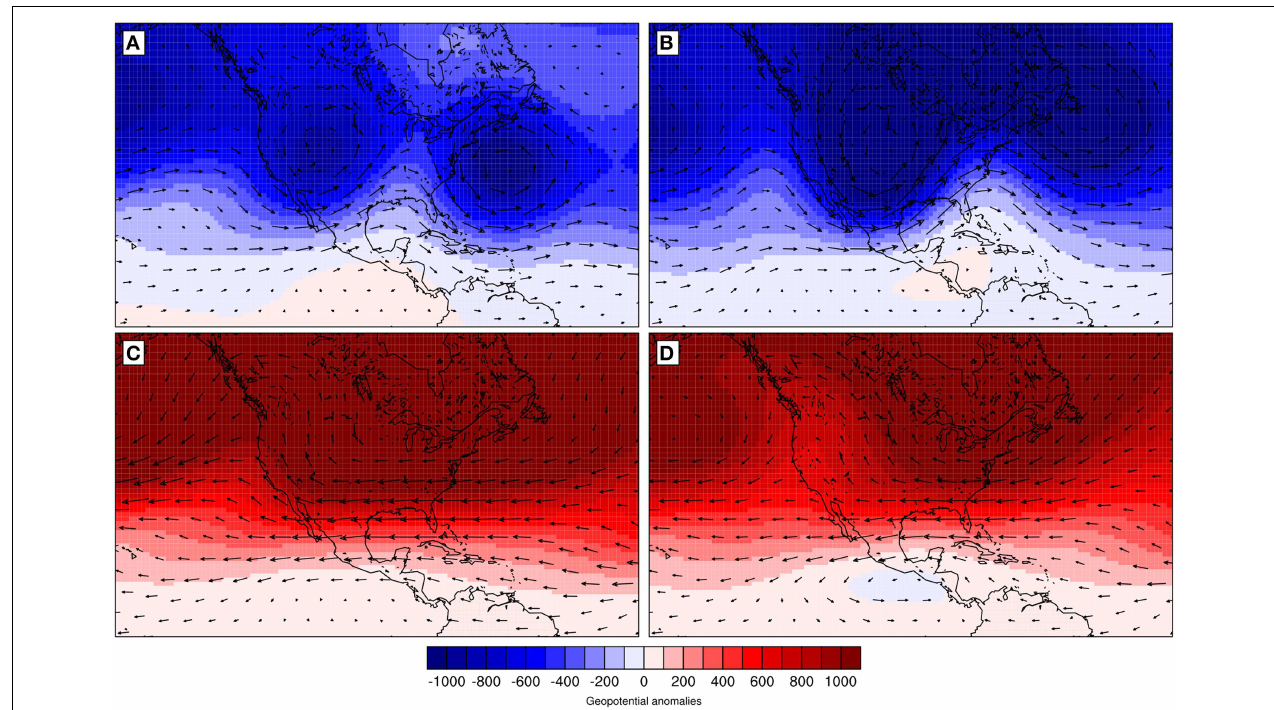
FIGURE 6 | Composited large-scale anomalies at 500 hPa associated with (A) SPAG, (B) SPNW, (C) SLLJ, and (D) SMWR regimes. Geopotential anomalies (colored pixels) and anomalous wind field (vectors).